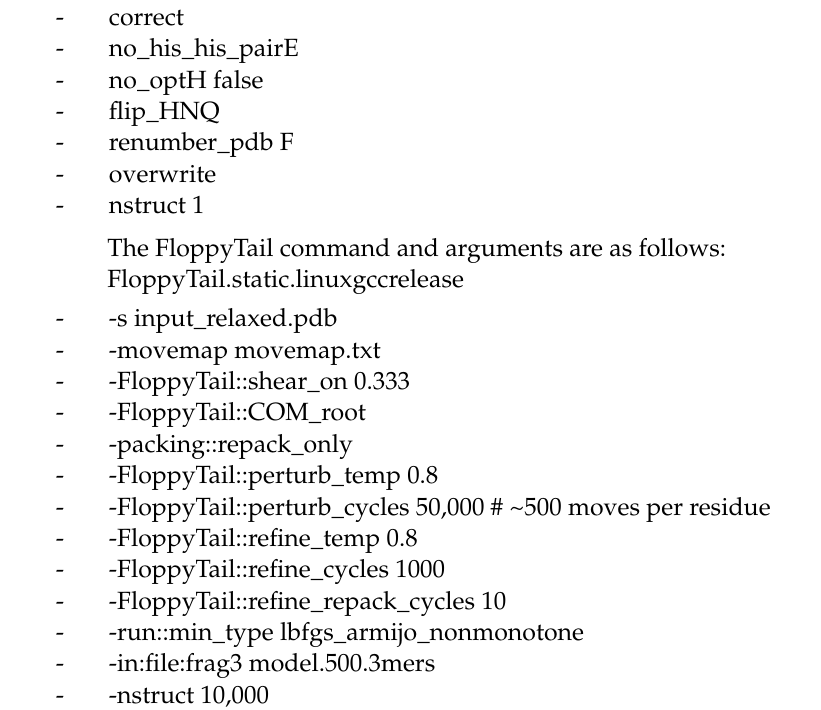
Figure 1; Supplemental Figure S2. Swimming motility assays of FliD domain swaps. Representative analysis of swimming motility of FliD domain swaps. Wild type, knockout and complemented strains are shown and individually labeled. Each bacterial growth was measured as described in Materials and Methods resulting in the data shown in Figure 2; Supplemental Figure S3.